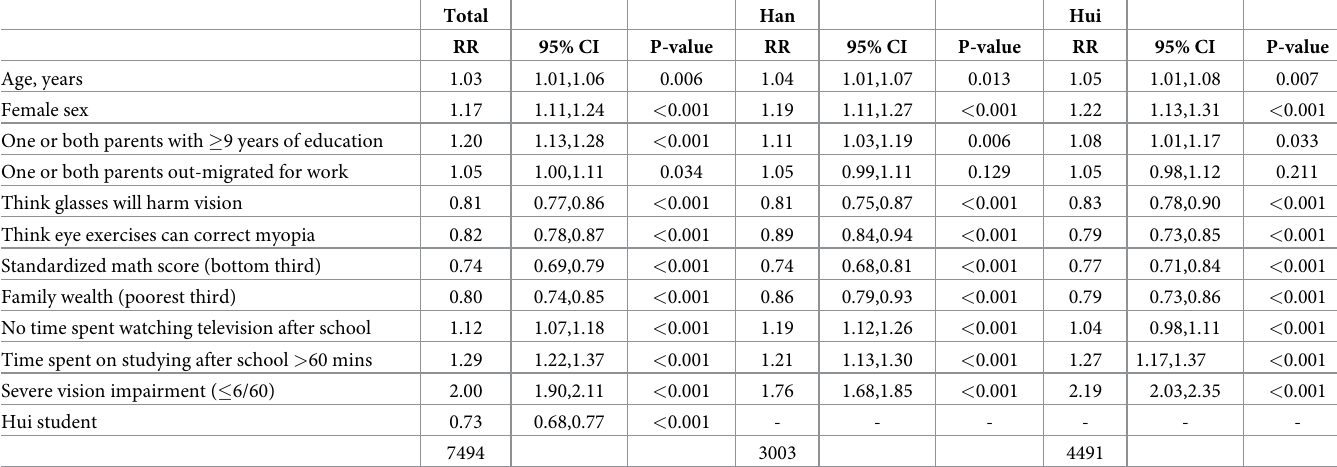
Table 3. Simple model: Potential associations with self-reported glasses ownership among students with uncorrected visual acuity < = 6/12 in both